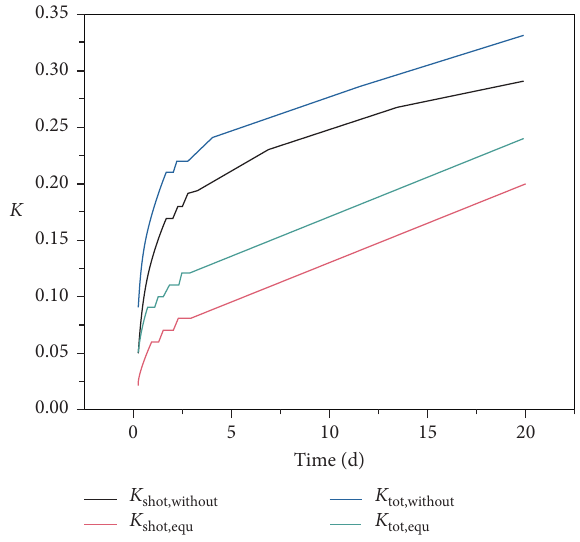
Figure 6: Stiffness comparison